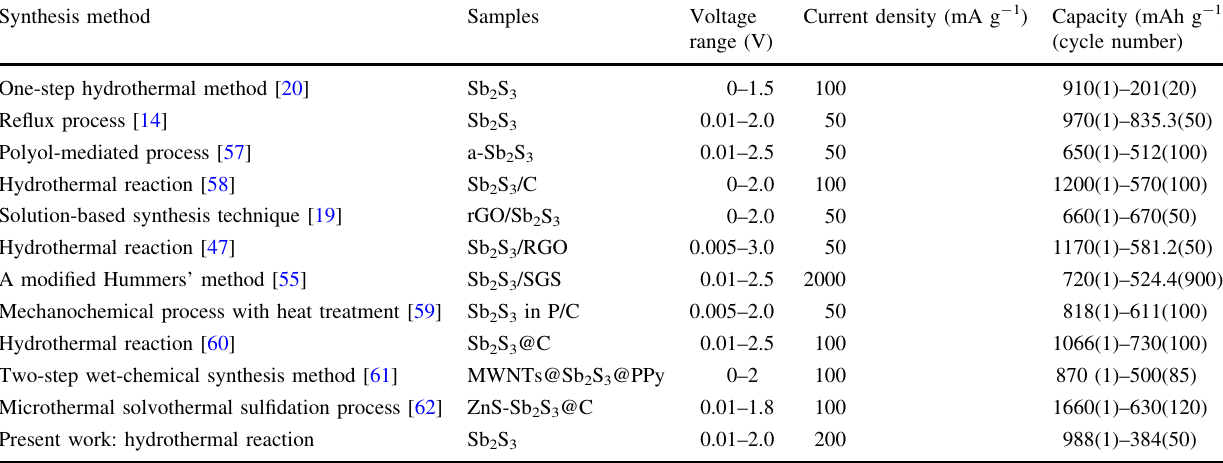
Table 4 Comparison of the performance between hierarchical Sb 2 S 3 hollow microspheres with other reported Sb 2 S 3 in studies as anode materials for